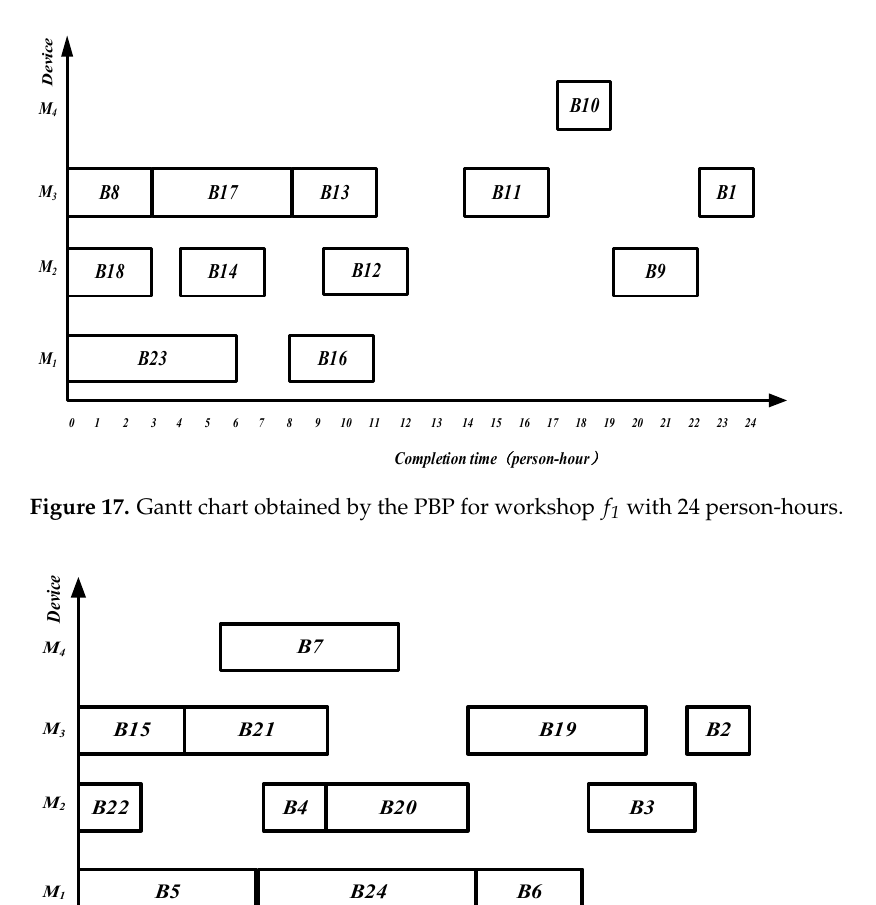
Figure 18. Gantt chart by the PBP for workshop f 2 with 19